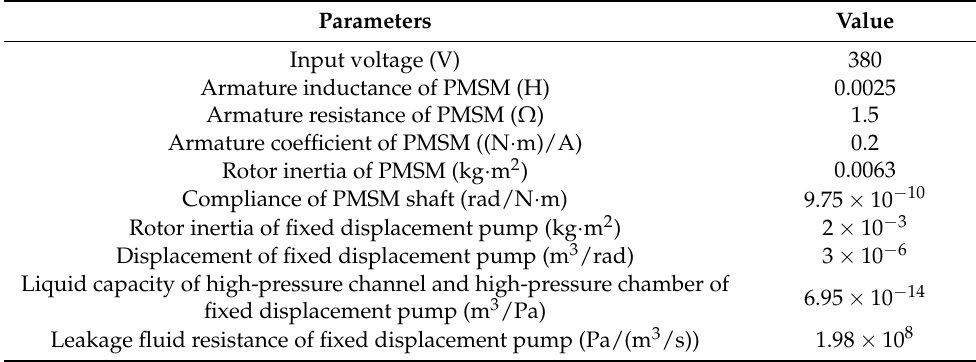
Figure 6. Simulink simulation model of the EHSPCS. System simulation parameters are shown in Table 1. Table 1. Simulation parameters of the electro-hydraulic servo pump control system (EHSPCS).